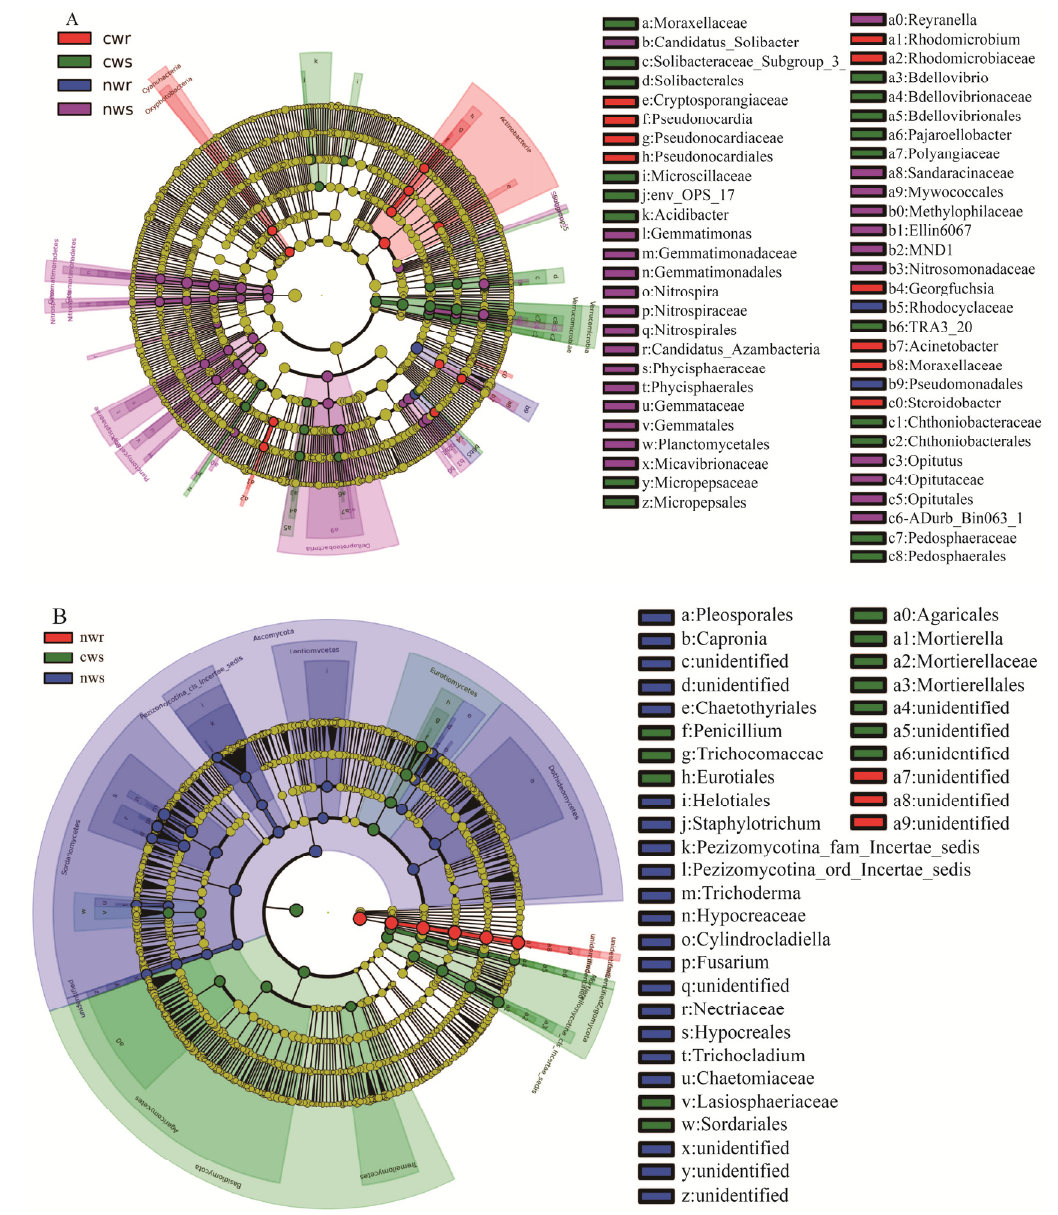
Figure 7. Bacterial ( A ) and fungal ( B ) taxa that contributed most to differences in microbial community composition. The linear discriminant analysis (LDA) effect size (LEfSe) analysis was performed to identify the indicator taxa representing each group, and the values were significant ( p < 0.05) when the LDA score was more than 2.